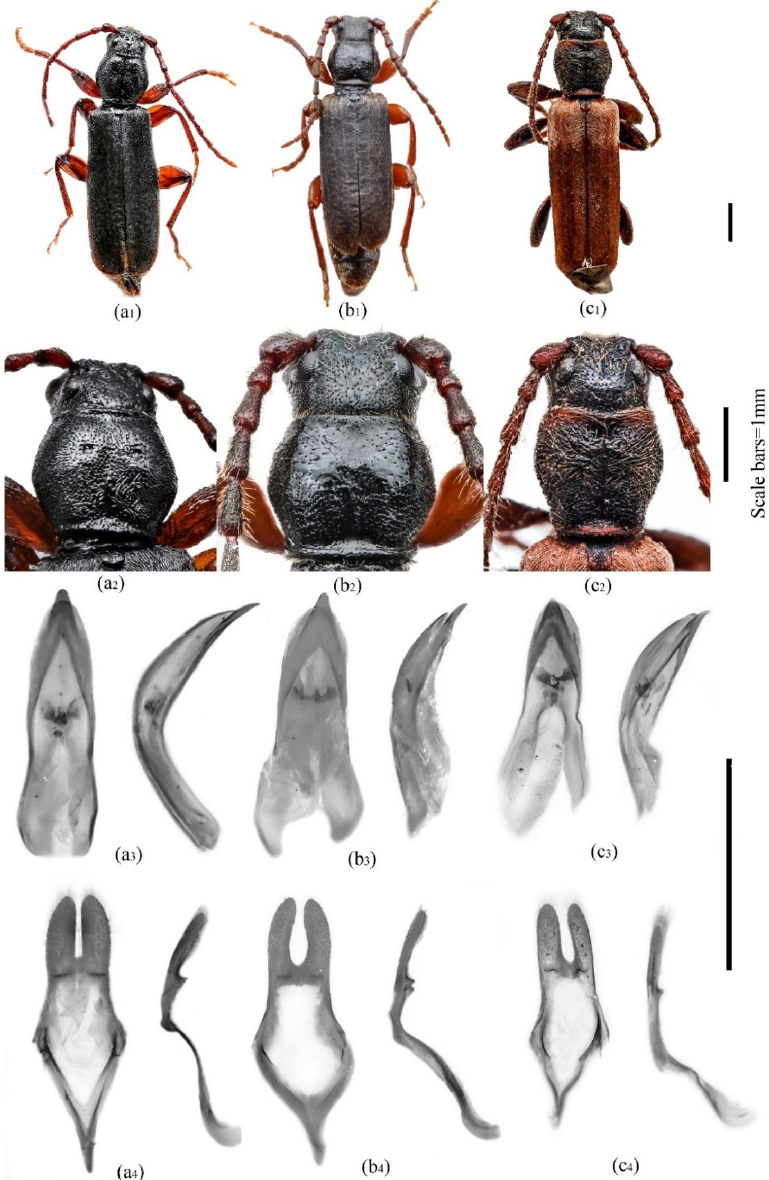
Figure 2. Comparative morphological characteristics among males of T. gabrieli ( a ), T. castaneum ( b ) and T. fuscum ( c ); ( a 1 , b 1 , c 1 ): habitus of adults (dorsal view); ( a 2 , b 2 , c 2 ): frontal part of habitus (dorsal view); ( a 3 , b 3 , c 3 ): adaeagus (ventral—in left side, and lateral in right side); ( a 4 , b 4 , c 4 ): parameres (ventral—in left side, and lateral in right side). The original photographs were prepared using the specimens collected in Lithuania and stored at T. Ivanauskas zoological museum, Kaunas, Lithuania.